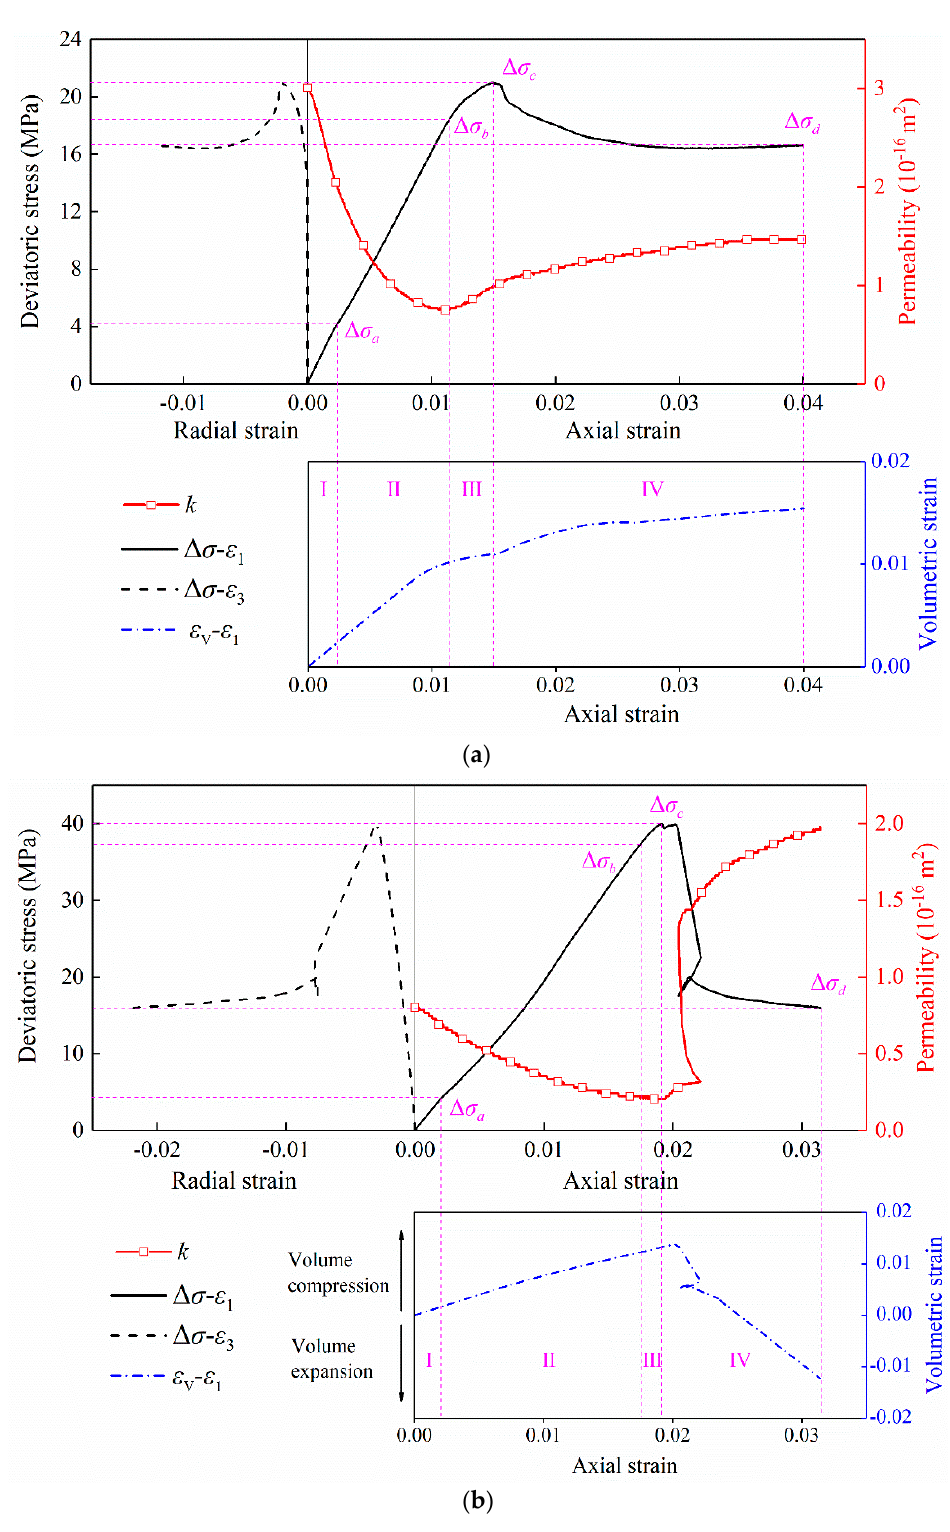
Figure 3. Stress-permeability-strain curves of coal under triaxial compression. ( a ) tectonic coal; ( b ) intact coal.